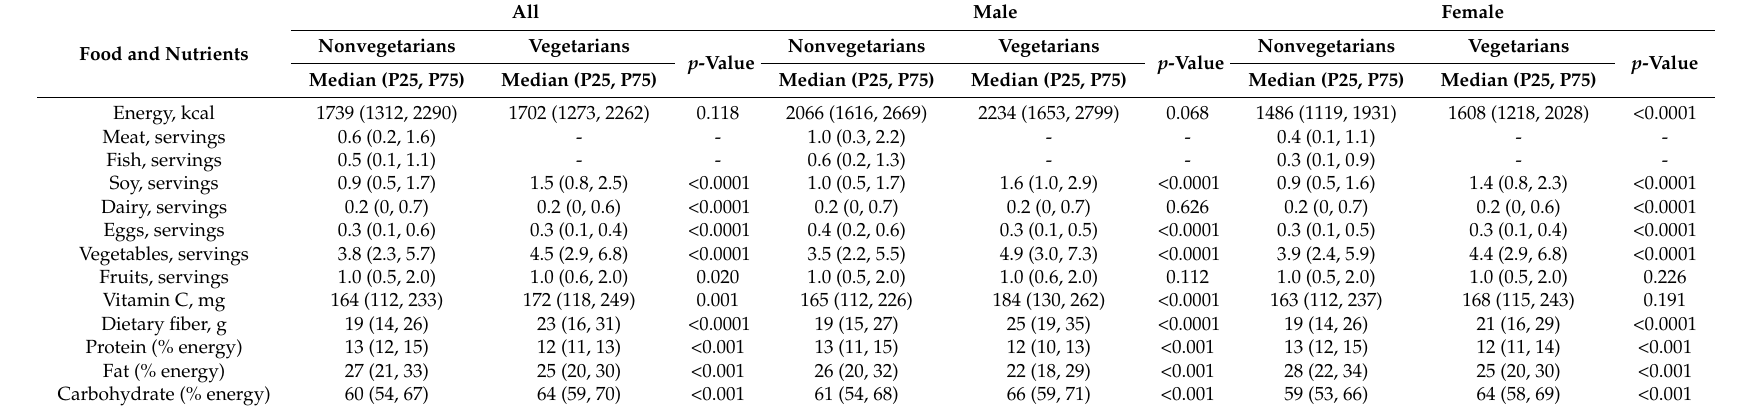
Table 2. Dietary intakes of vegetarians and nonvegetarians as assessed by food frequency